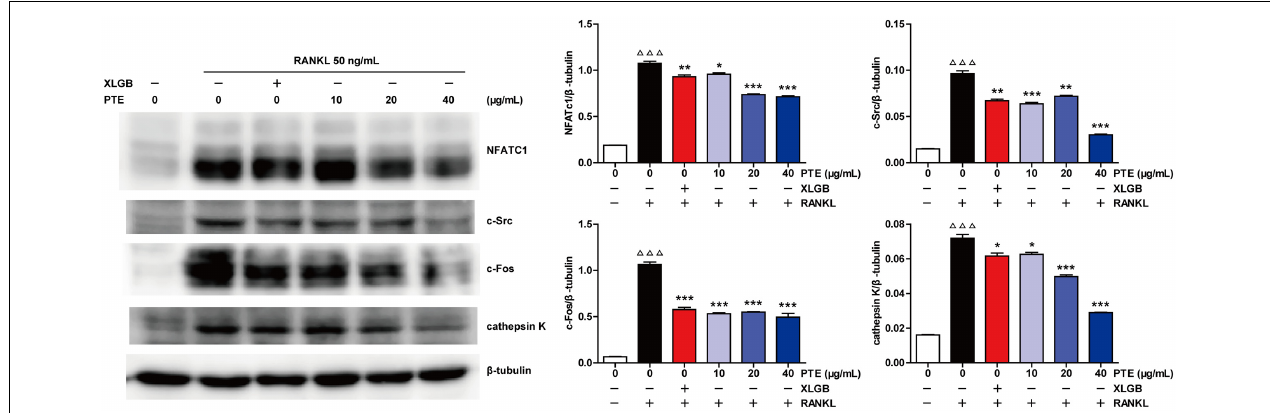
FIGURE 6 | Pu-erh tea extract inhibited the expression of the RANKL-induced osteoclast-specific proteins. NFATc1, c-Src, c-Fos, cathepsin K, and β -tubulin levels were detected by western blotting, and the results were quantified using AlphaView software. Representative images are displayed. Values are shown as the mean ± SEM of three independent experiments. (cid:77)(cid:77)(cid:77) P < 0.001 versus the control; and ∗ P < 0.05, ∗∗ P < 0.01, and ∗∗∗ P < 0.001 versus only RANKL-treated